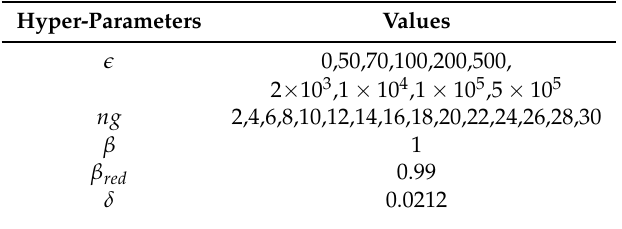
Table 1. Values of each hyper-parameter configuration for this